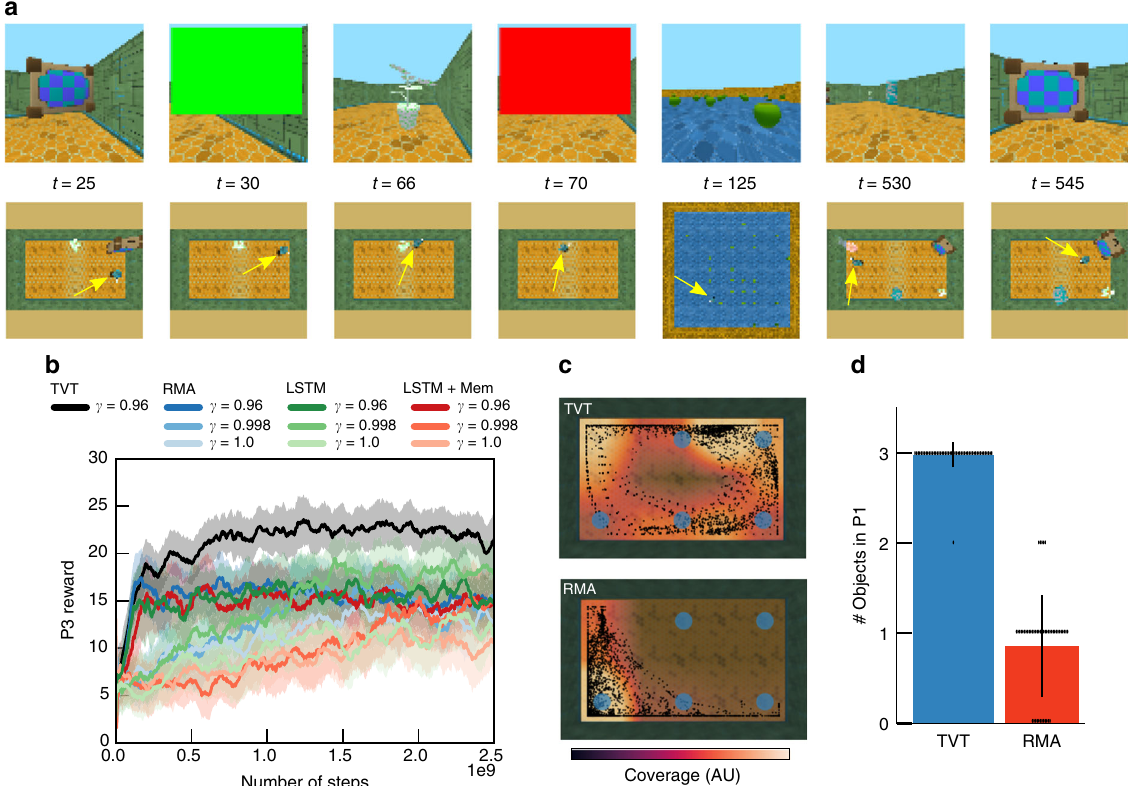
Fig. 6 More complex information acquisition. a In Latent Information Acquisition, the agent (yellow arrow) must touch three procedurally generated objects to identify from a subsequent color fl ash if each is either green or red. In P3, green objects yield positive reward and red objects negative. b TVT performed well on this task (black curve; Supplementary Movie 4). The non-TVT agents touched all objects in P3 without regard to their value, thus achieving on average 15 points, whereas TVT discriminated between the good and bad objects. Error bars represent standard errors across fi ve agent training runs. c In 20 trials, we plot the positional coverage in P1 of a TVT agent compared to RMA. TVT developed exploratory behavior in P1: it navigated among the six possible locations where the P1 objects could be placed, whereas the RMA typically moved into the corner. d A quanti fi cation over 50 trials of the exploratory behavior in P1: TVT usually touched all three of the objects in P1, whereas RMA touched about one. Each dot represents the value in one trial. The error bars indicate one standard